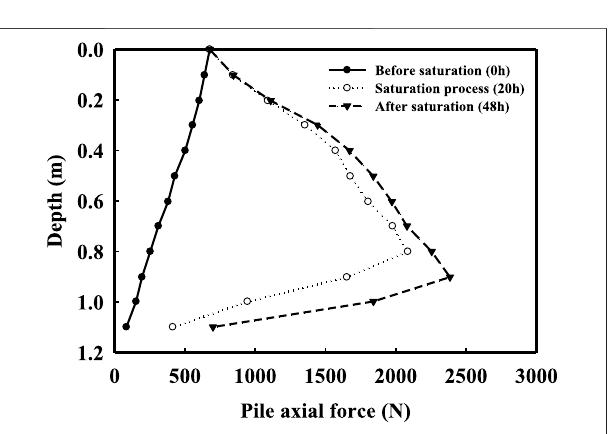
FIGURE 11 | Variations of volumetric water content distribution with the time of PITC.